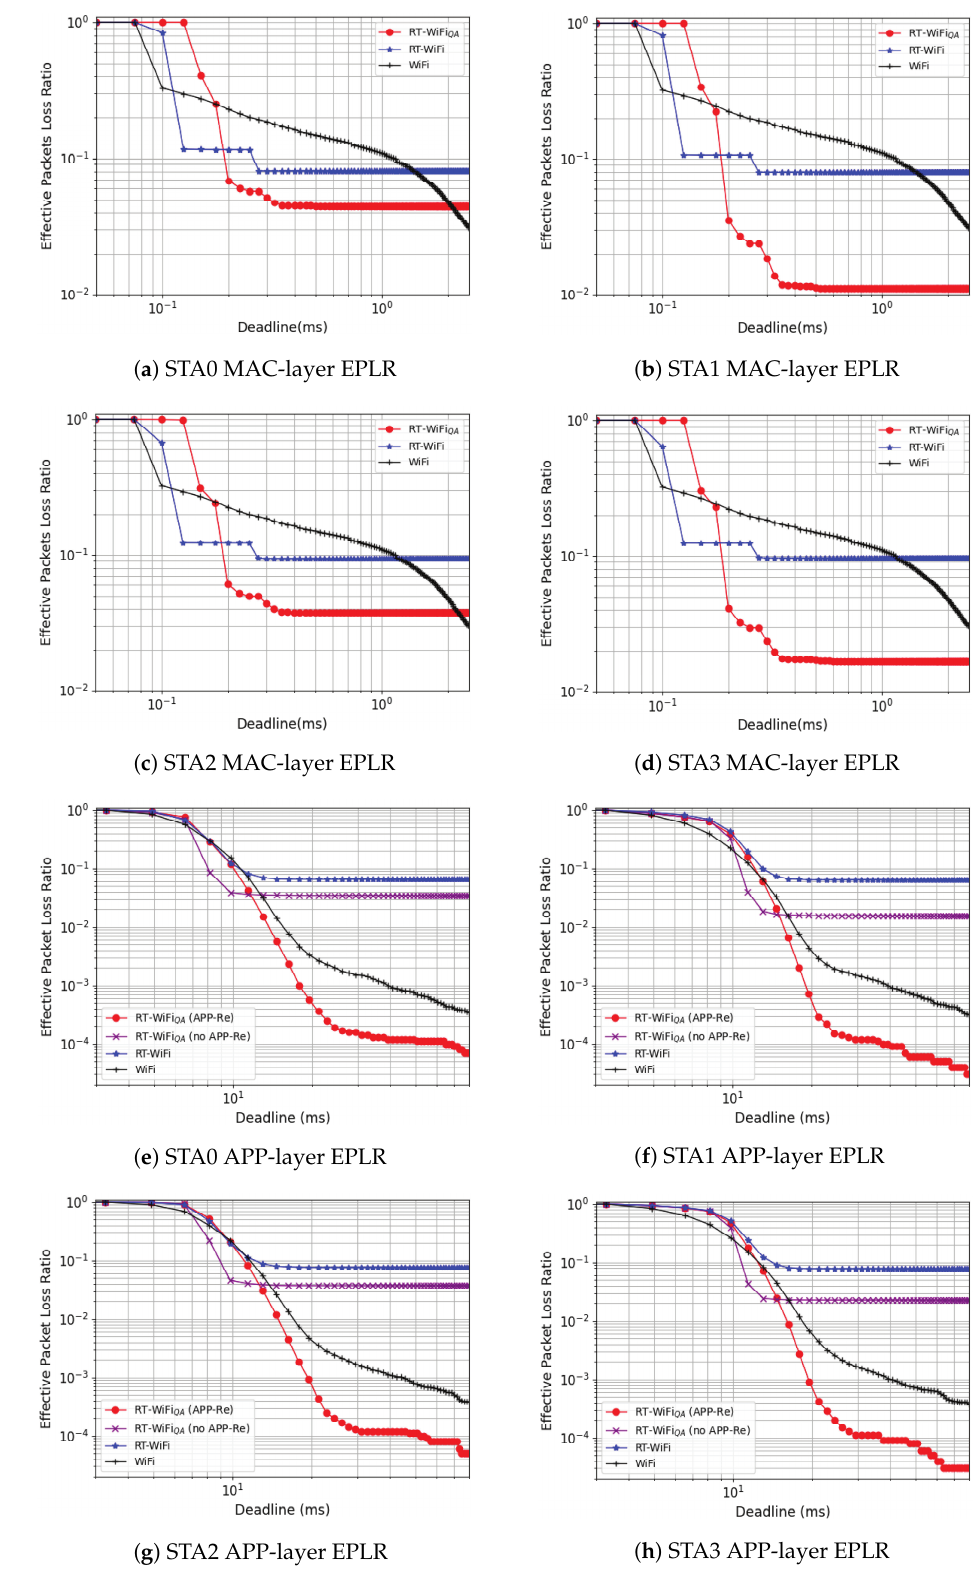
Figure 7. CCDF curves of RT-WiFiQA EPLR performance in terms of the deadline requirements, compared with RT-WiFi and WiFi. Figure 7a–d show the MAC-layer EPLR, and Figure 7e–h show the APP-layer